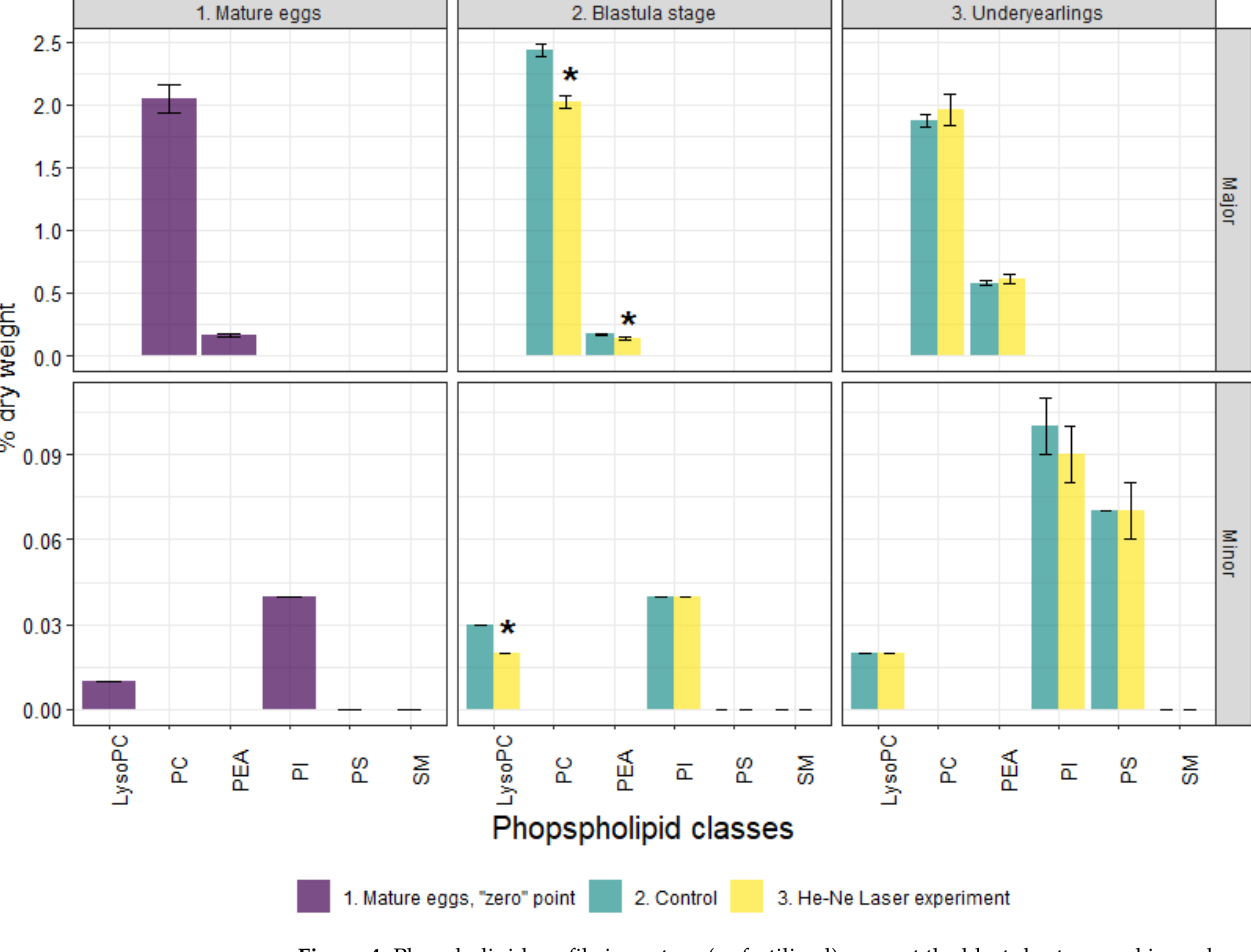
Figure 4. Phospholipid profile in mature (unfertilized) eggs, at the blastula stage and in underyear- lings of Atlantic salmon in control and experiment. *—significantly different ( p < 0.05) between groups. lings of Atlantic salmon in control and experiment. * — significantly different ( p < 0.05) between LysoPC—lysophosphatidylcholine, PC—phosphatidylcholine, PEA—phosphatidylethanolamine, groups. LysoPC — lysophosphatidylcholine, PC — phosphatidylcholine, PEA — phosphati- PI—phosphatidylinositol, PS—phosphatidylserine, dylethanolamine, PI — phosphatidylinositol, PS — phosphatidylserine, SM — sphingomye- lin.